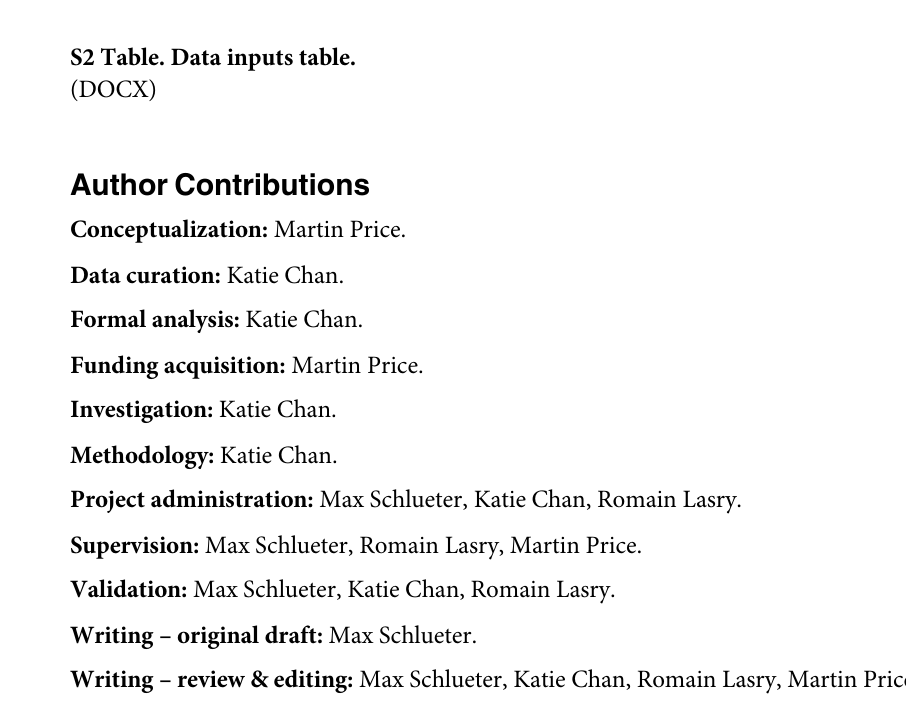
S2 Table. Data inputs